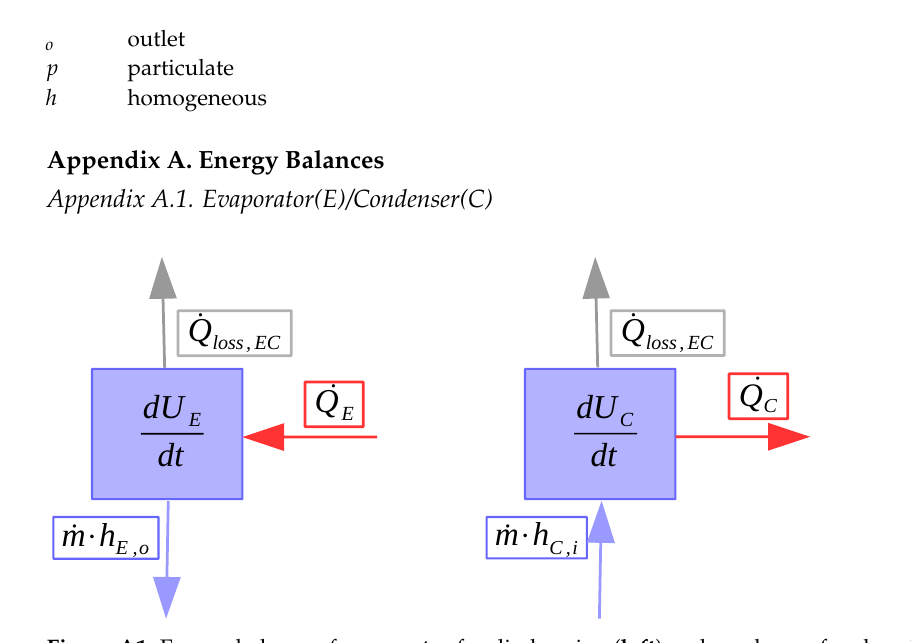
Figure A1. Energy balance of evaporator for discharging ( left ) and condenser for charging ( right